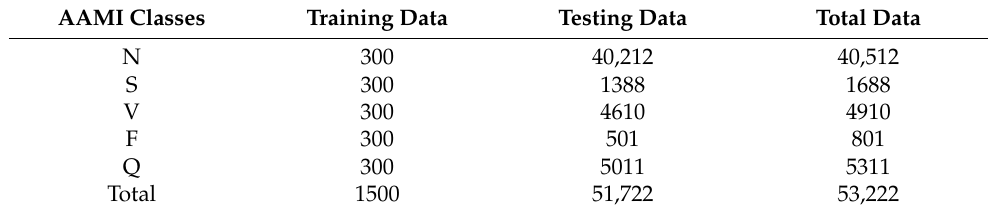
Table 2. A summary of the 5 classes of beat